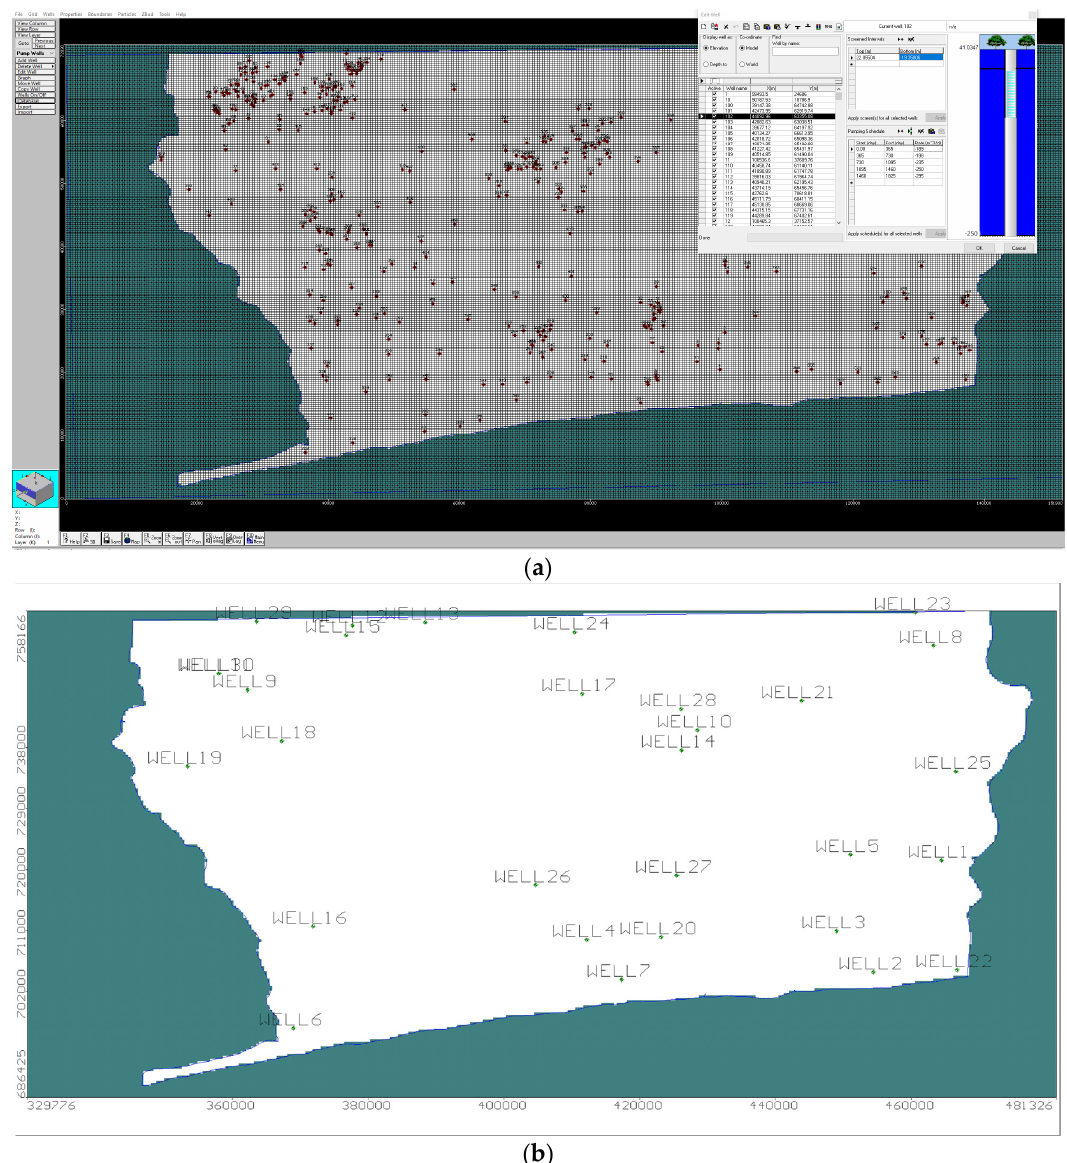
Figure 2. ( a ): Geographic location of pumping wells imported to the model and used for simulation in Visual MODFLOW; ( b ): spatial distribution of monitoring wells.